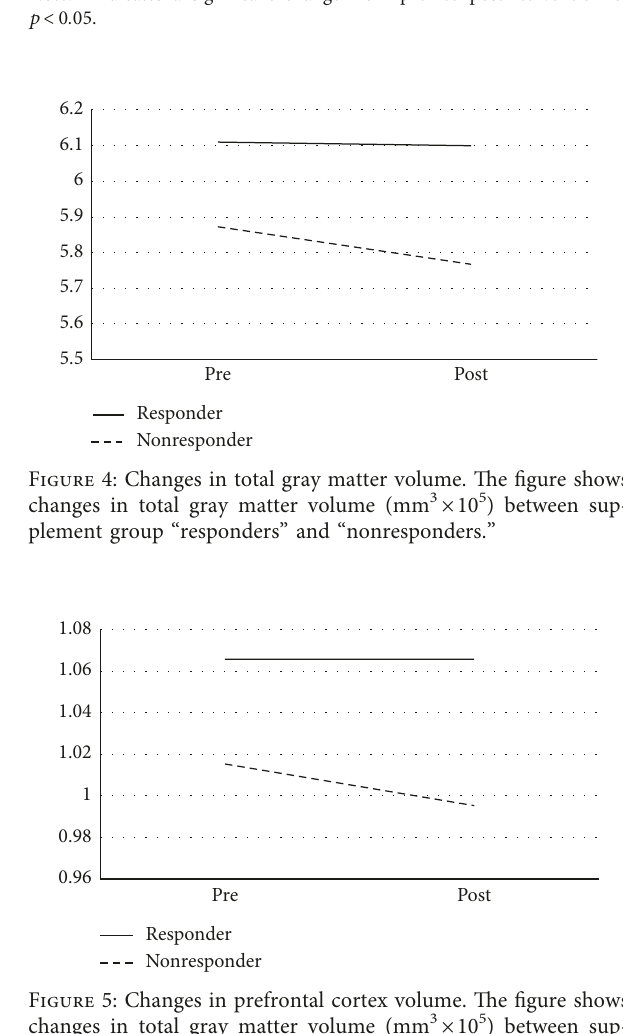
10 5 ) between sup- ×